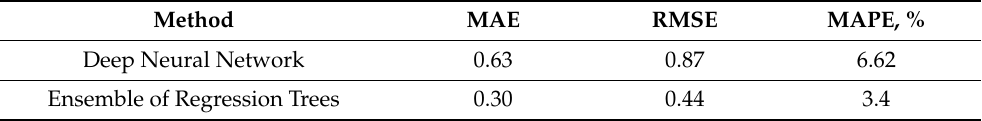
Table 7. Comparative characteristics of the work of the implemented methods on the test sample when determining the tensile strength in bending.